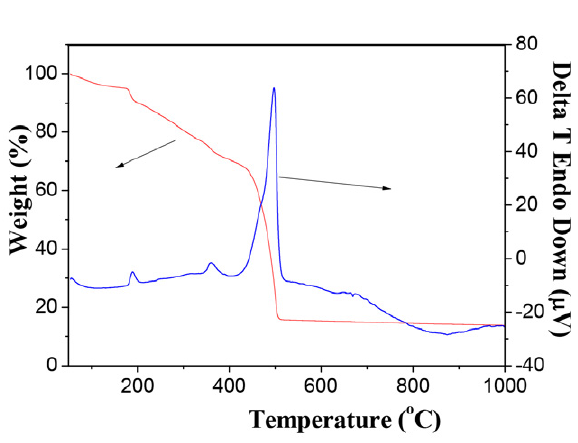
Figure 4. DT-TGA curves of complex 2